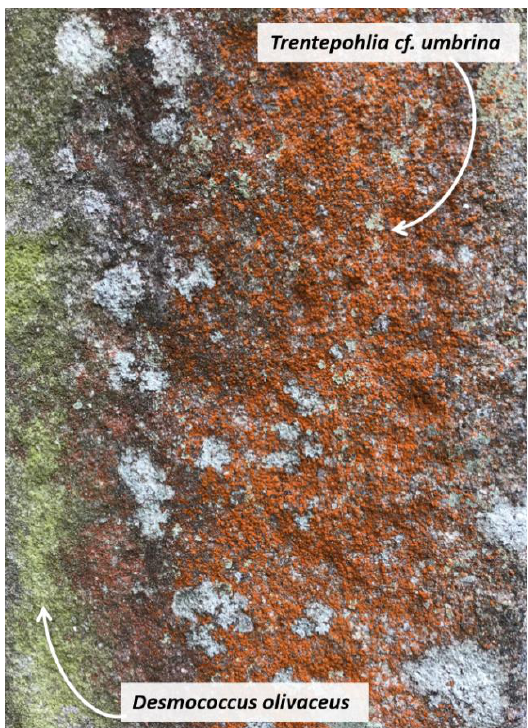
Figure 3. Example of dominance of Trentepohlia cf. umbrina on the N-facing wall of the BAR church.